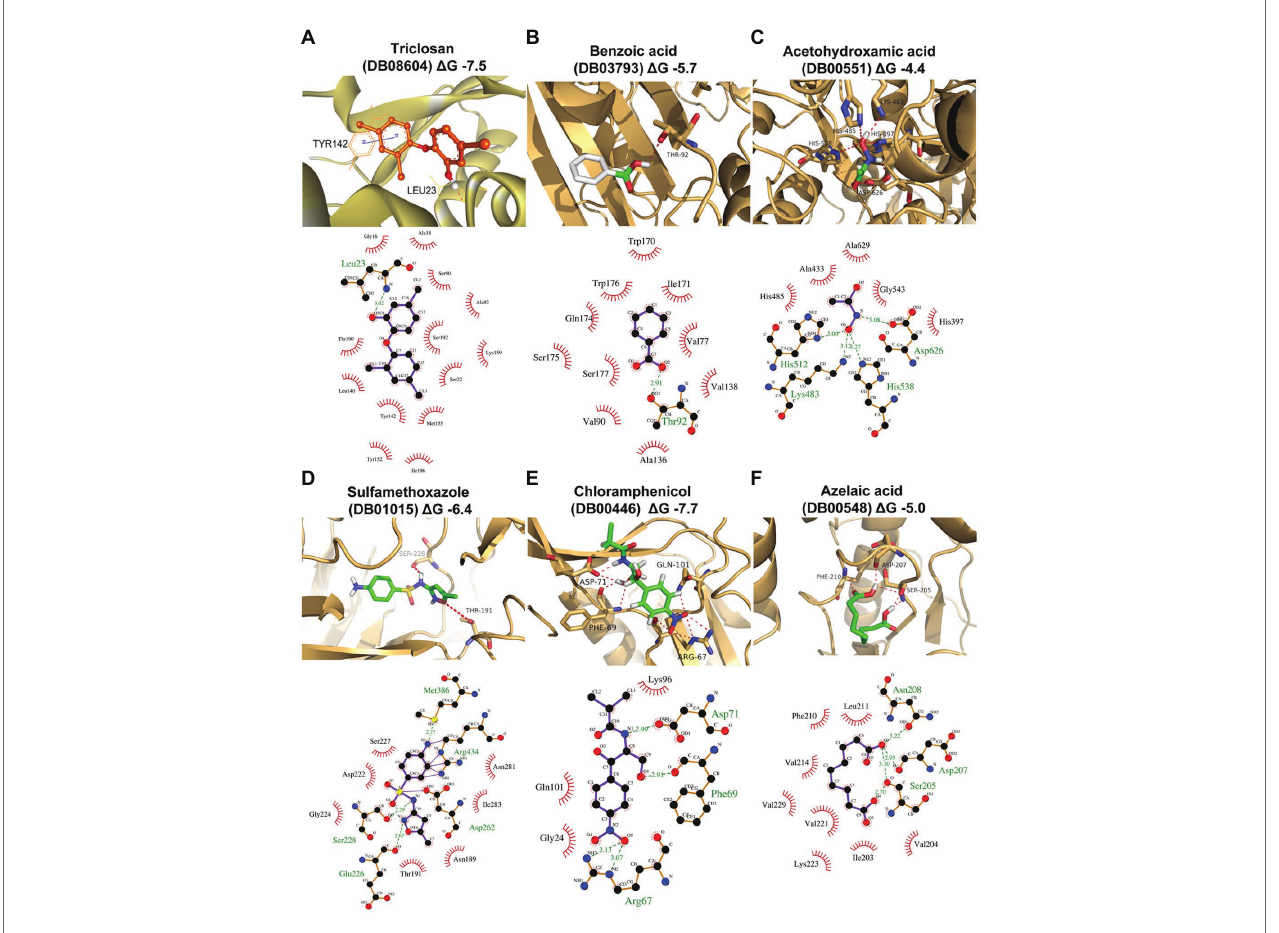
FIGURE 4 | Homology modeling and docking of the tested compounds with their respective target proteins. For each of the protein-ligand complexes, the LigPlot cartoons show the interactions between each inhibitor and the amino acid residues in the active site cleft of the respective proteins. (A) SPRG_20215 with triclosan (DB08604; binding energy − 7.5 kcal/mol), (B) SPRG_02663 with benzoic acid (DB03793; binding energy − 5.7 kcal/mol), (C) SPRG_06801 (putative urease) with acetohydroxamic acid (DB00551; binding energy − 4.4 kcal/mol), (D) SPRG_19504 with sulfamethoxazole (DB01015; binding energy − 4 kcal/mol), (E) SPRG_35021 with chloramphenicol (DB00446; binding energy − 7.7 kcal/mol), and (F) SPRG_13682 with azelaic acid (DB00548; binding energy − 5.0